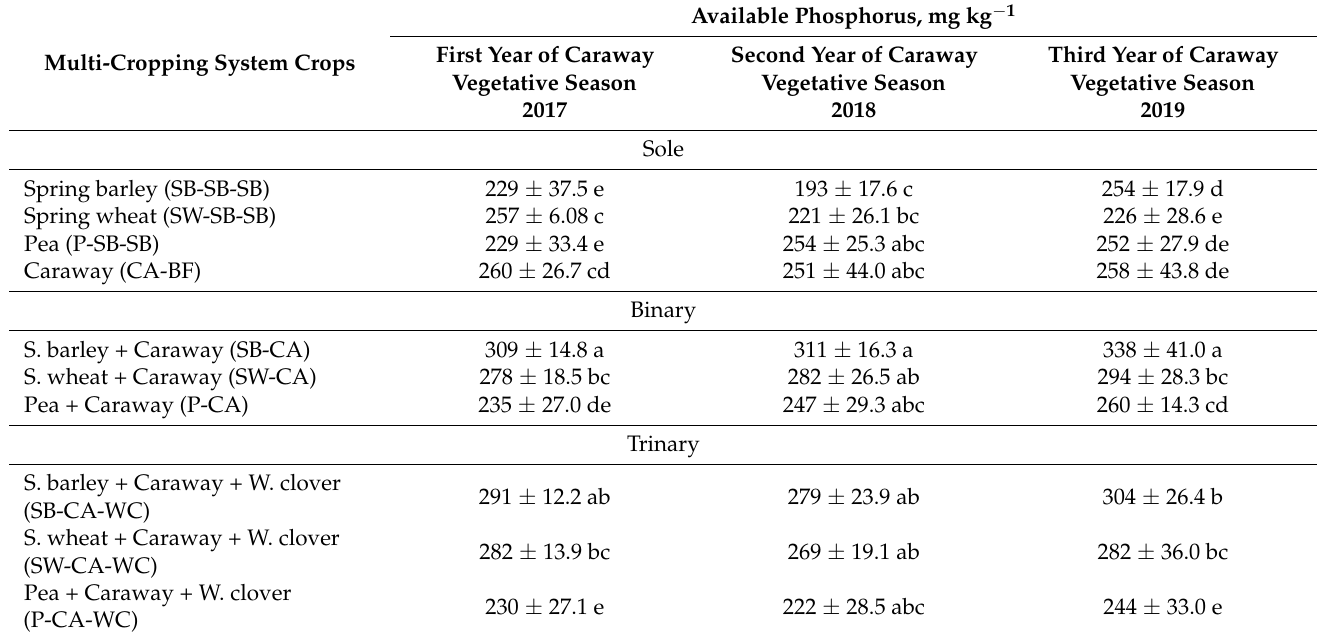
Table 3. Available phosphorus content in the soil of sole, binary, and trinary crops in 2017–2019.